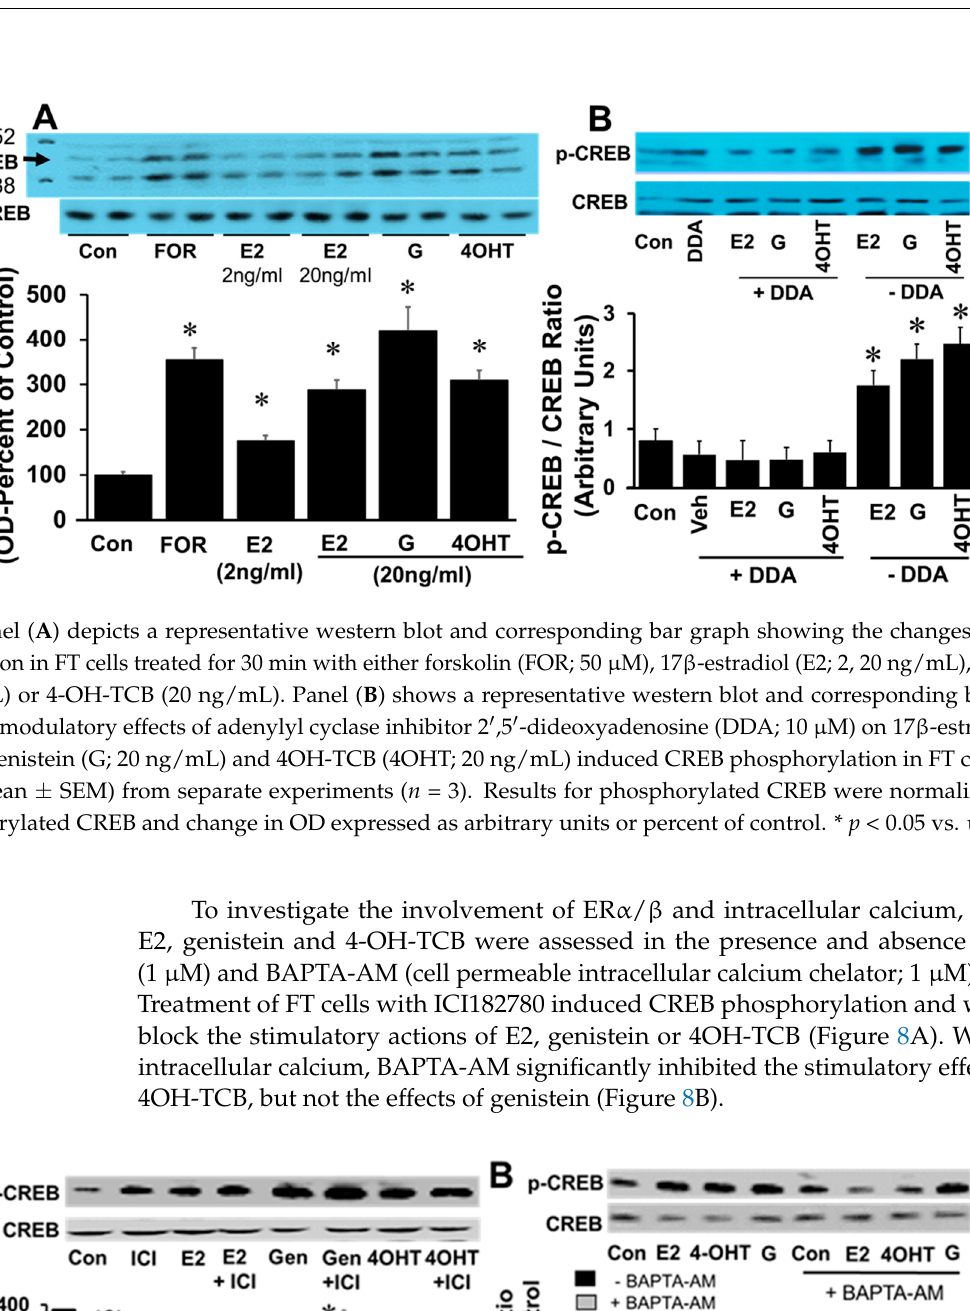
12 of 22 Figure 6. Panel ( A ) is a representative western blot showing the time-dependent (5, 10 and 30 min) phosphorylation of CREB (43 kDa protein) in response to 17 β -estradiol (E2; 20 ng/mL) and Panel ( B ) shows a blot with CREB phosphorylation after 30 min, in response to E2 (20 ng/mL) and BSA tagged E2 (E2-BSA; 20 ng/mL). Bar graph depicts densitometric analysis for changes in CREB phosphorylation and presented in arbitrary units following normalization with non-phosphorylated CREB. Data (mean ± SEM) are from 3 separate experiments each in duplicates. Results were normalized by the internal standard, CREB. * p < 0.05 vs. 0 min or untreated control. The effects of E2 on CREB phosphorylation were also mimicked by EEs. Treatment with 2 and 20 ng/mL E2 induced p-CREB in a concentration-dependent fashion. Exposure to forskolin, E2 (20 ng/mL), genistein (20 ng/mL), and 4-OH-TCB (20 ng/mL) increased